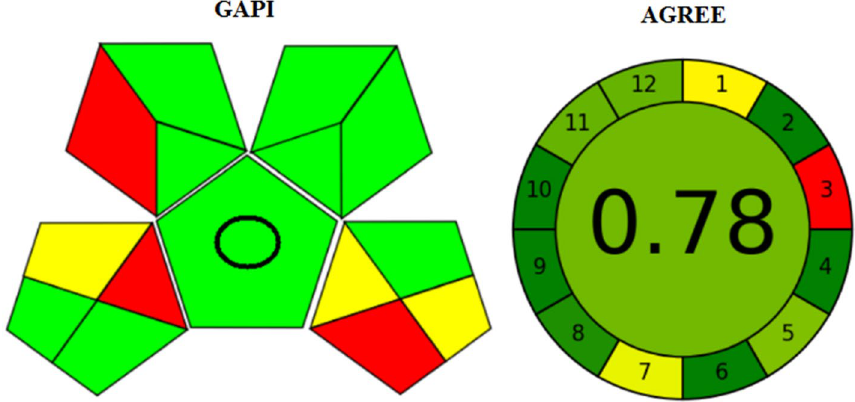
Figure 7. Results of greenness assessment of the proposed methods using AGREE and GAPI